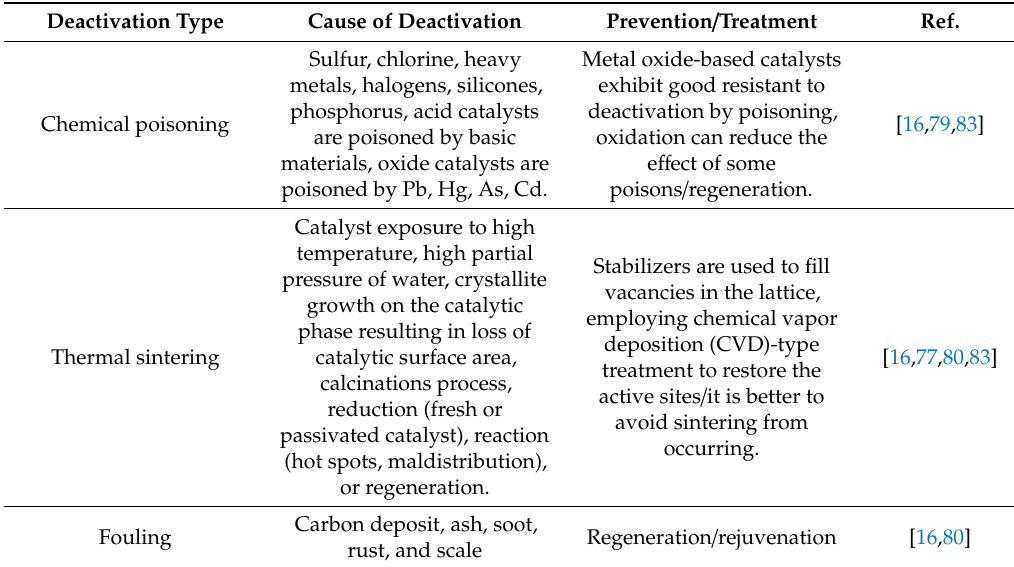
Table 4. Types and causes of catalyst deactivation.